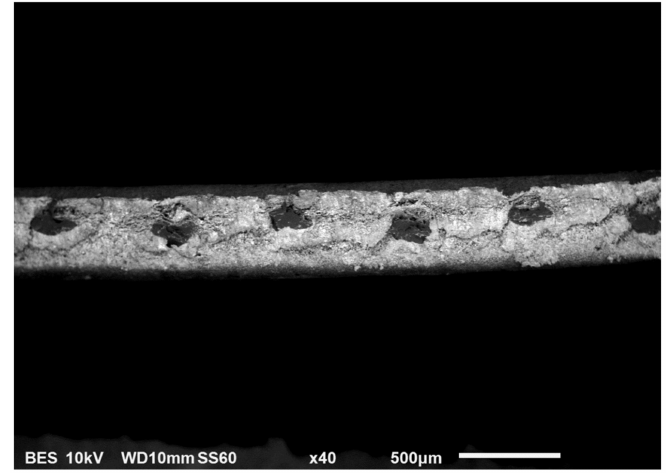
Figure 1. Cross section of a 500 µ m thick Zirfon Perl 500 UTP ®